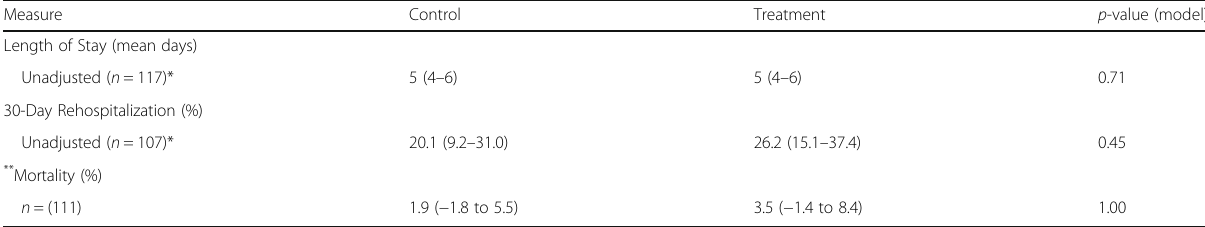
Table 5 Morbidity and Mortality outcomes by thiamine supplementation Measure Control